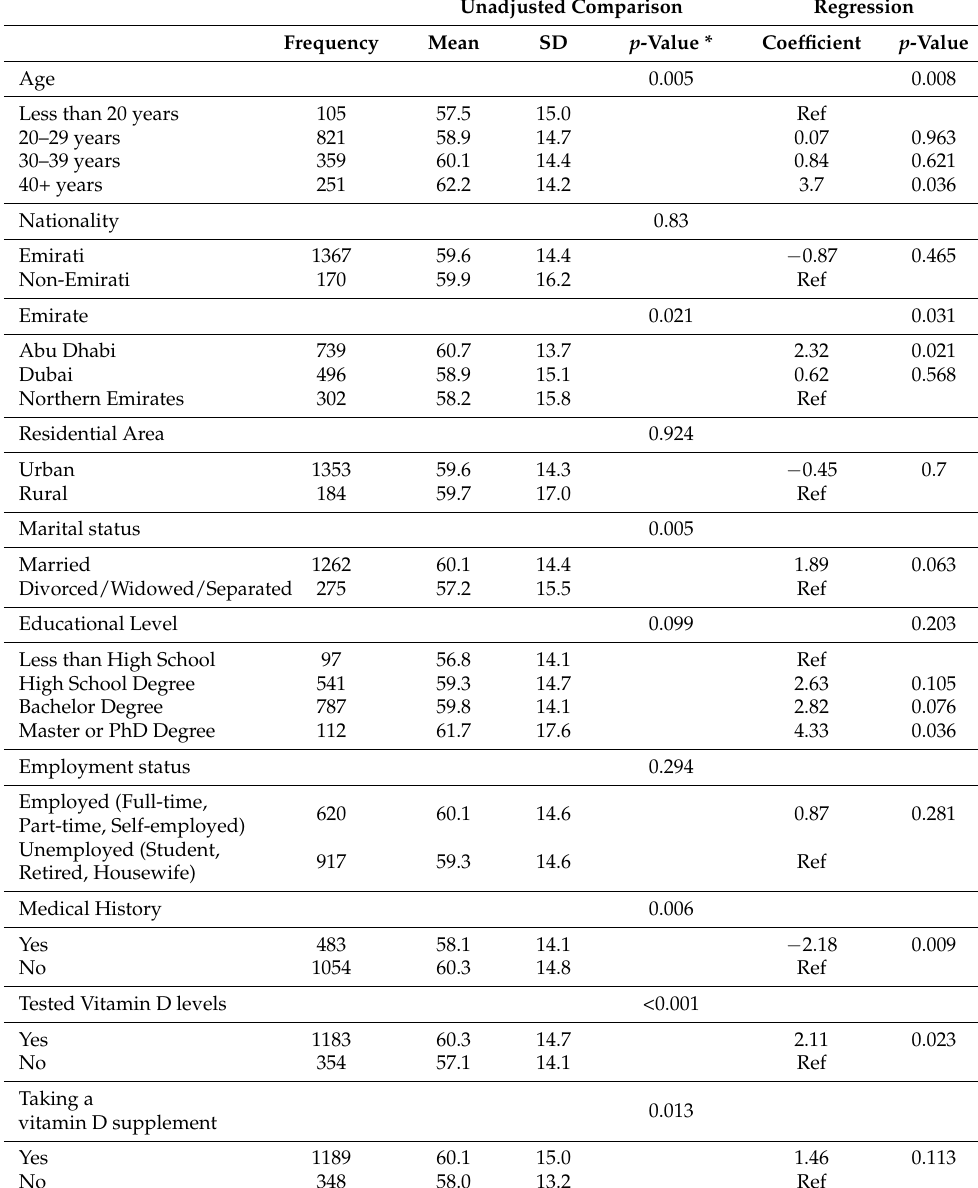
Table 4. Determinants of nutritional